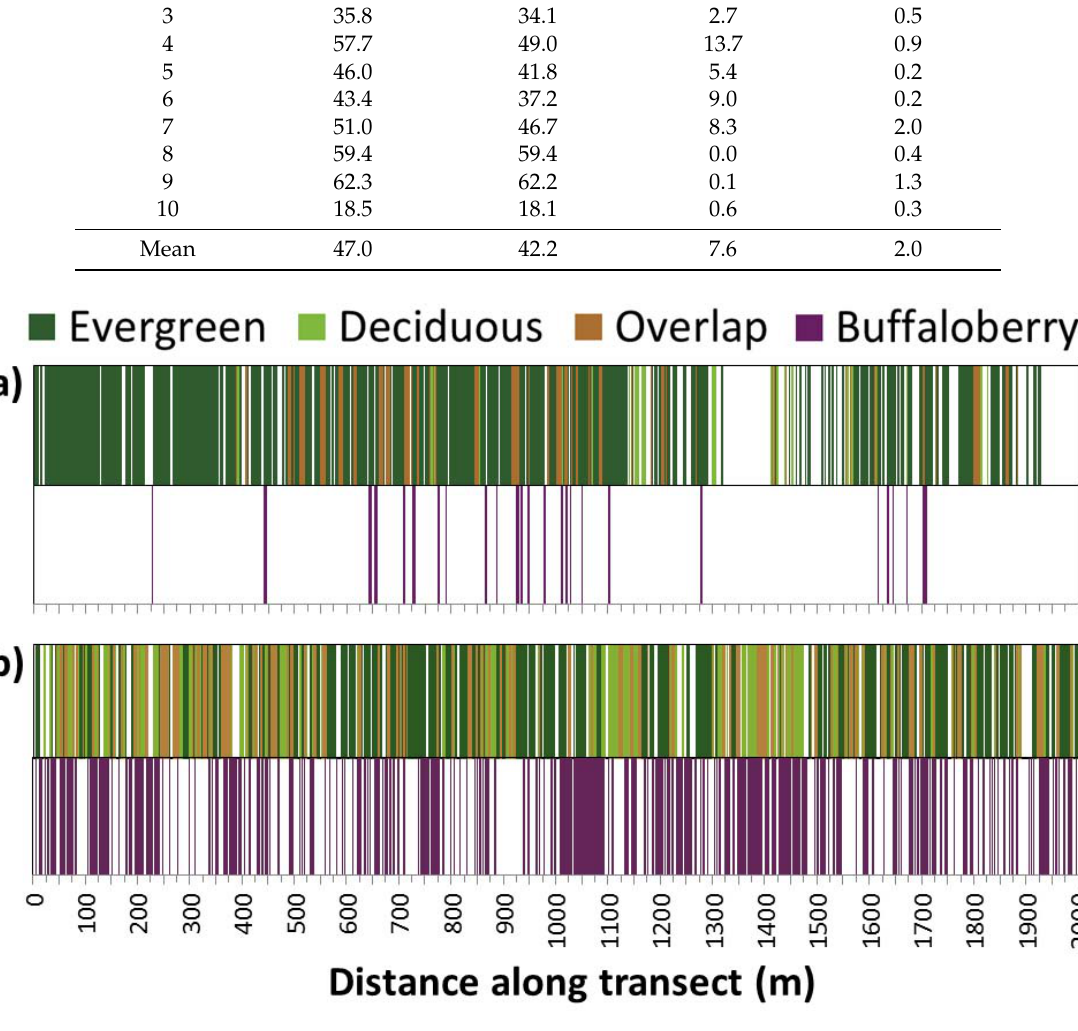
Figure 3. Example of raw forest canopy (upper bar) and buffaloberry shrub (lower bar) line-intercept transect data for two 2-km replicates ( n = 10) representative of ( a ) average patch size and distribution; and ( b ) maximum cover of canopy and buffaloberry recorded during field sampling near Hinton, Alberta. The overlap refers to the presence of both evergreen and deciduous canopy within a given segment along a transect.